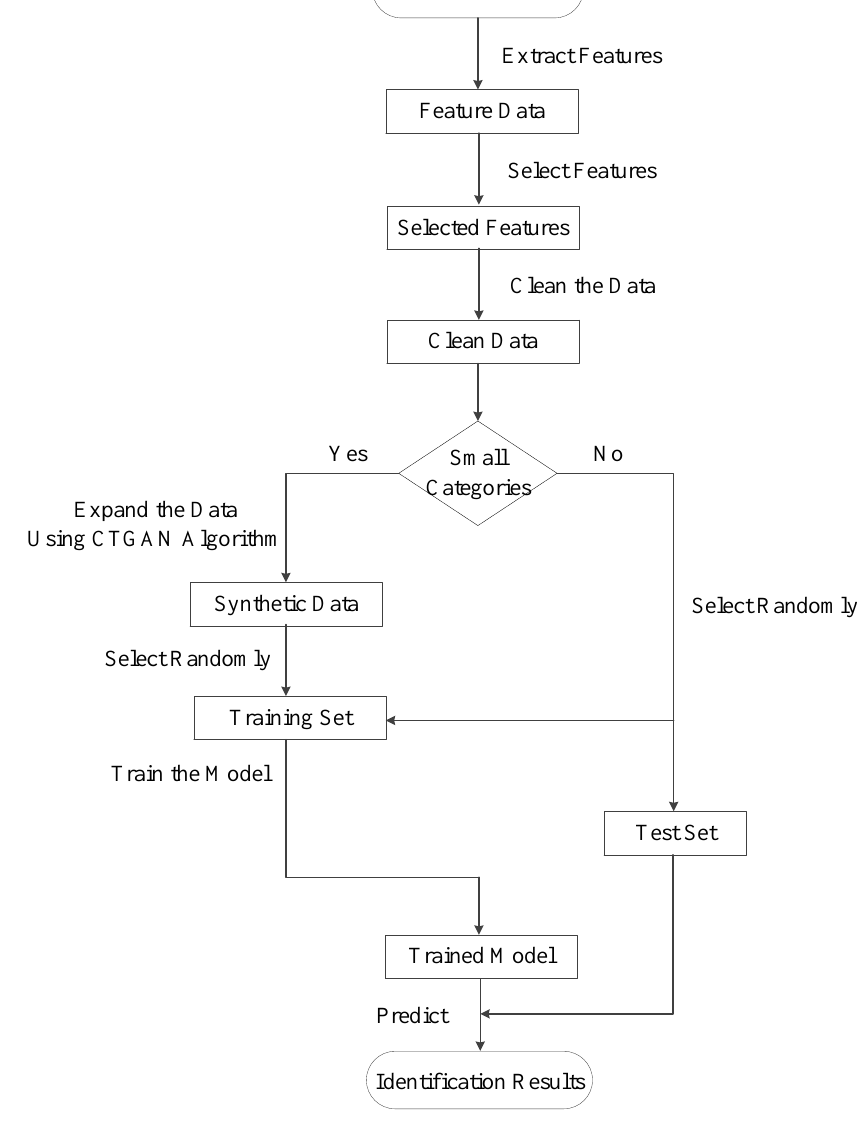
Figure 3. CTTGAN step flow